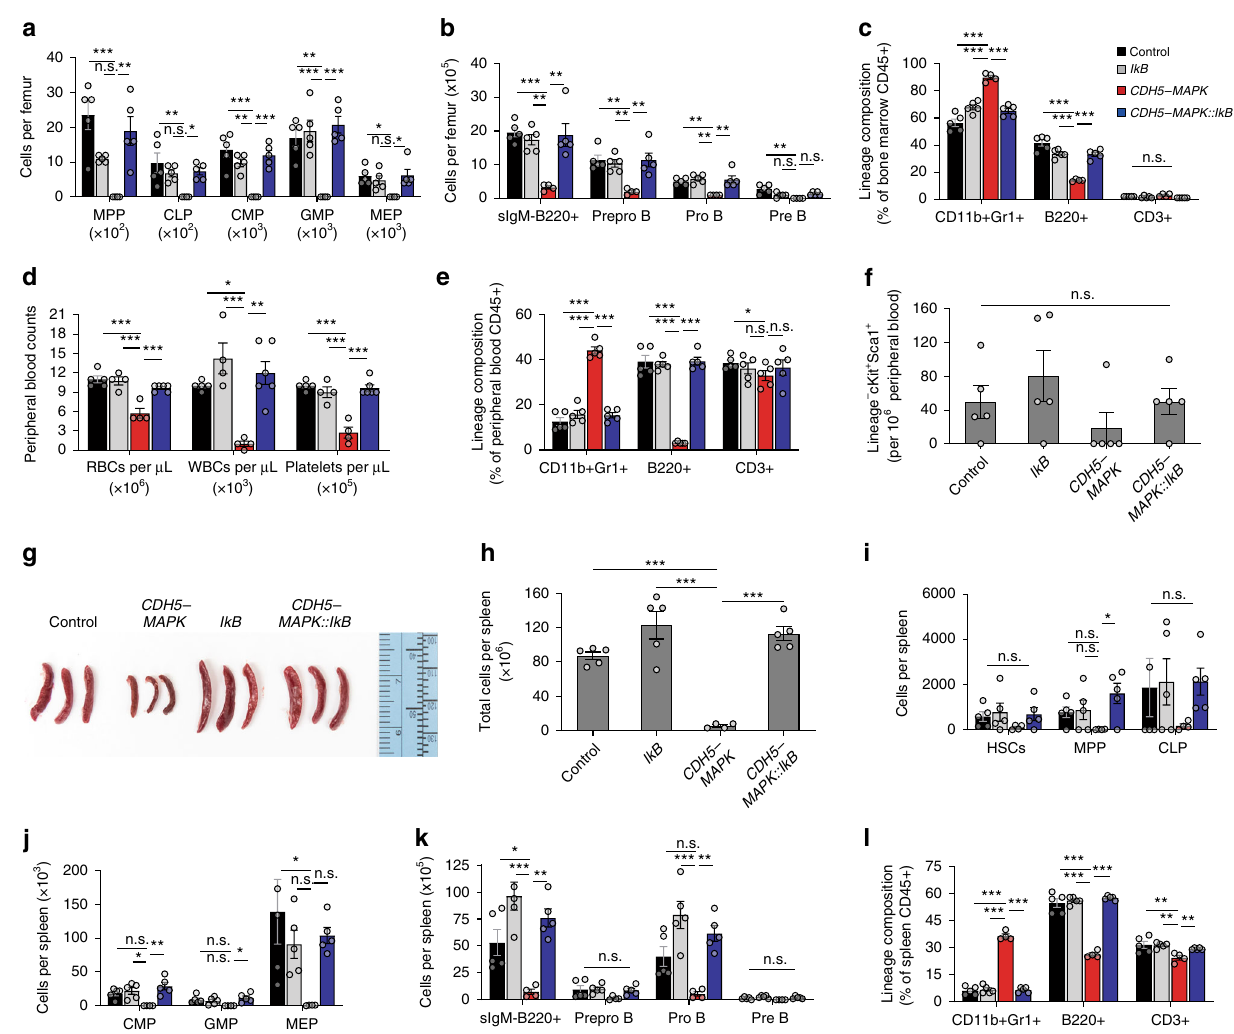
Fig. 5 Endothelial NF- κ B inhibition restores hematopoietic progenitor activity in CDH5-MAPK mice. a , b Total cells per femur of the indicated hematopoietic progenitors estimated by fl ow cytometry ( n = 4 – 5 mice/cohort). Gating strategy described in Supplementary Fig. 2e, f. c Lineage composition of CD45 + cells within BM ( n = 4 – 5 mice/cohort). d Steady-state peripheral blood counts ( n = 4 – 6 mice/cohort). e Lineage composition of CD45 + cells within peripheral blood ( n = 5 mice/cohort). f HSPC frequency in peripheral blood ( n = 5 mice/cohort). g Gross images of spleen from the indicated genotypes. h Spleen cellularity in the indicated genotypes ( n = 4 – 5 mice/cohort). i – k Total cells per spleen of the indicated hematopoietic progenitors ( n = 4 – 5 mice/cohort). l Lineage composition of CD45 + cells within spleen ( n = 4 – 5 mice/cohort). Note that crossing CDH5-MAPK with Tie2. IkB-SS mice ( CDH5-MAPK::IkB ) restores the hematopoietic and HSPC attributes of CDH5-MAPK mice to control levels. Error bars represent sample mean ± SEM. One-way ANOVA for multiple comparisons and Tukey ’ s correction was performed to determine signi fi cance. * P ≤ 0.05; ** P < 0.01; *** P < 0.001; n.s. P >